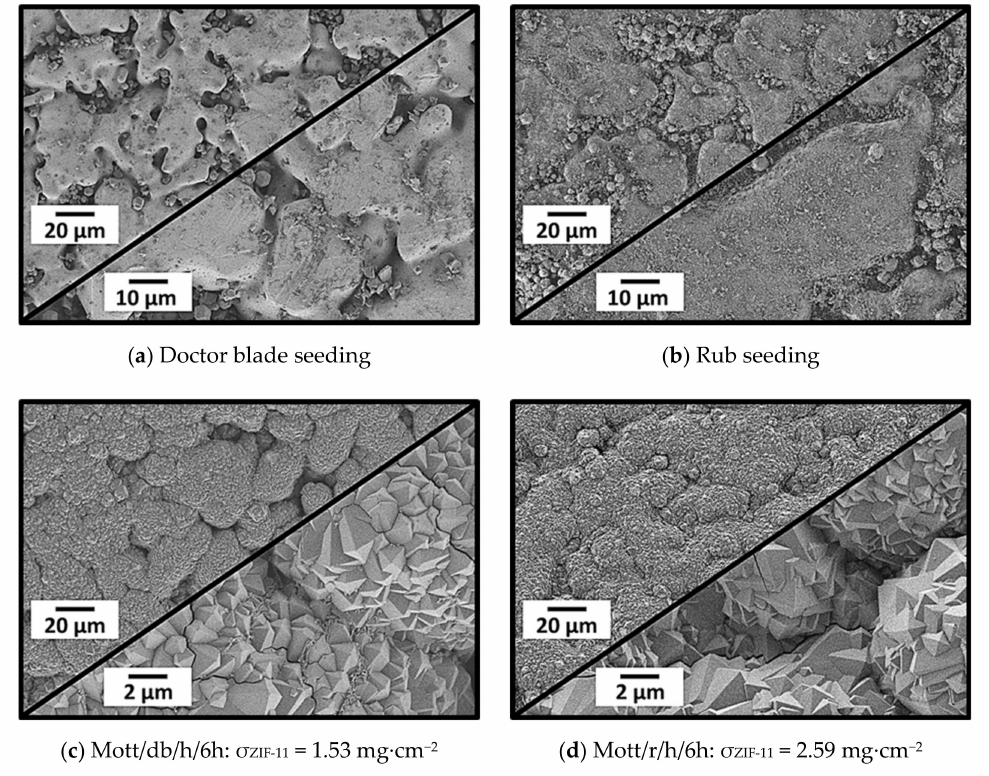
Figure 14. SEM images of stainless-steel supports (Mott) after ( a ) doctor blade and ( b ) rub seeding, as well as ( c , d ) the corresponding ZIF-11 layers after 6 h of secondary growth in DEF at 60 ◦ C. Compared to drop seeding, fewer ZIF-11 crystals were present inside the pores of the support after doctor blade seeding (Figure 14a). However, at higher magnification, fine particle fragments were visible, which where most likely formed by shearing the seeds with the razor blade. For rub seeding, pores were completely filled with ZIF-11 seeds, and significantly more particle fragments covered almost the complete support